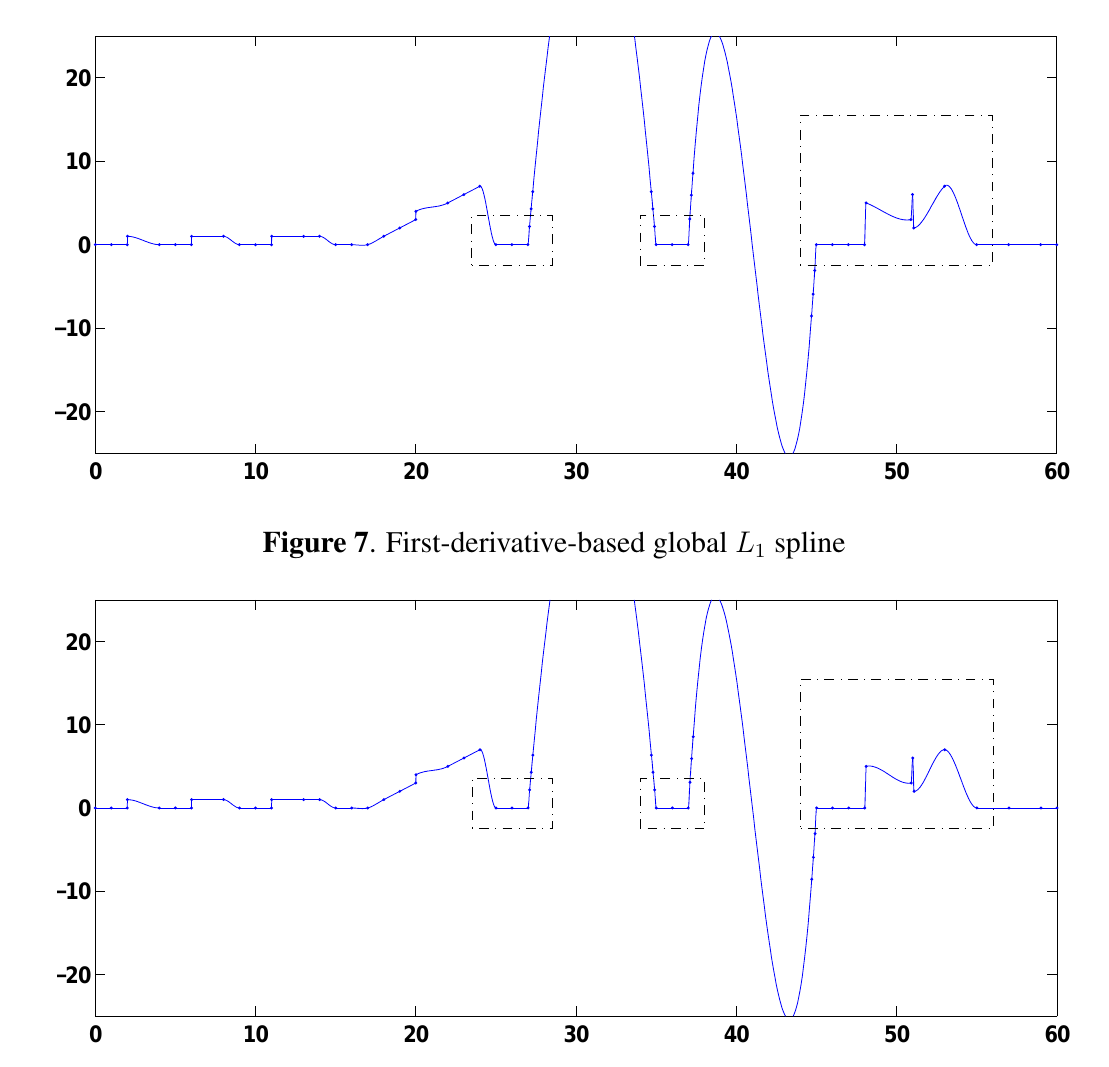
Figure 6 . First-derivative-based 7-point-window L